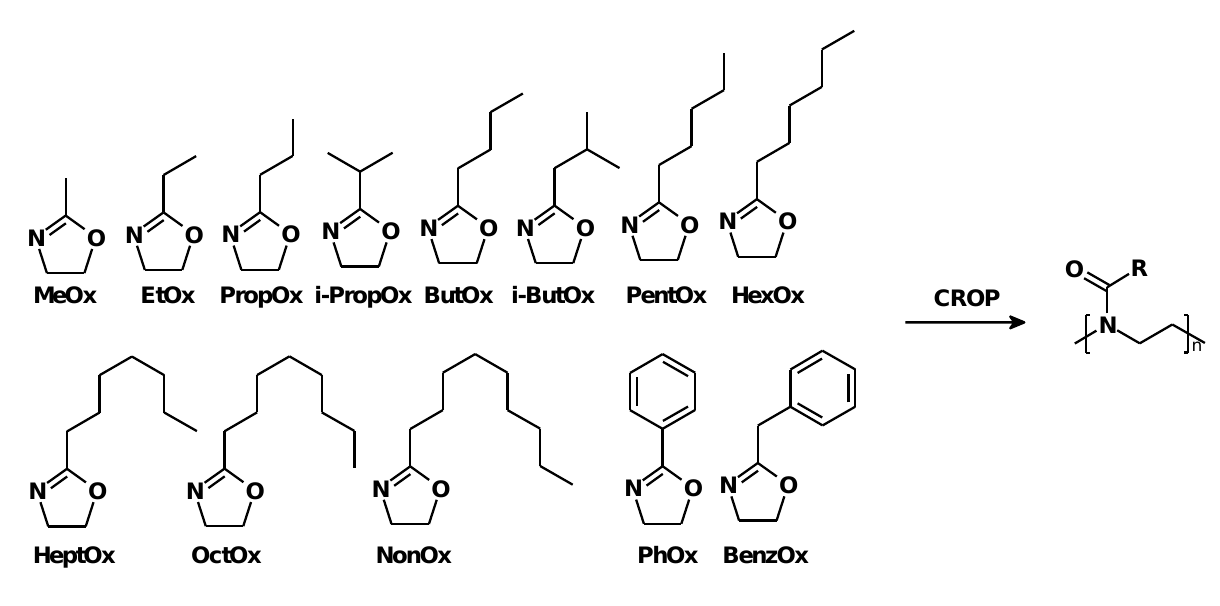
Scheme 1. Schematic representation of the structures of the investigated 2-oxazolines and the corresponding poly(2-substituted-2-oxazoline)s prepared by cationic ring-opening polymerization